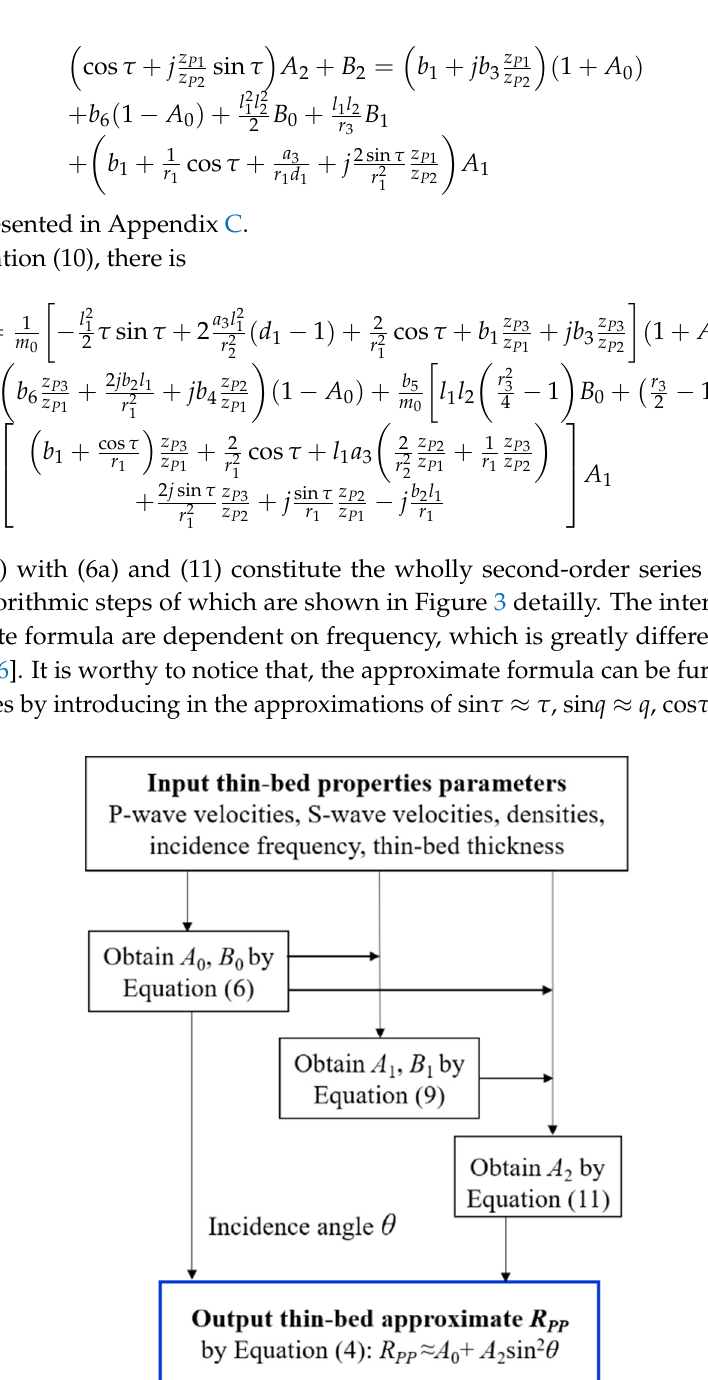
Table 1. Rock properties of thin-bed models, units of velocities and densities are m/s and g/cm 3 , respectively. Layer No.